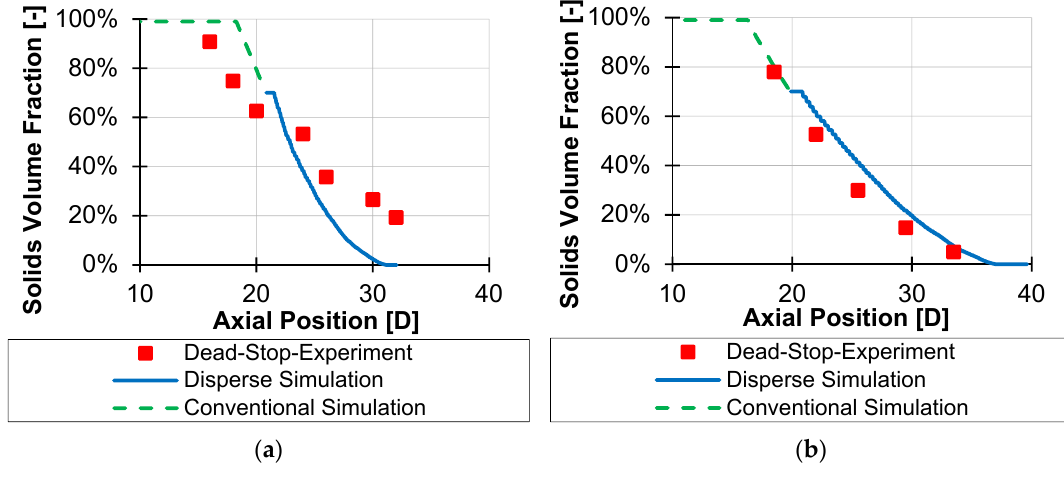
Figure 21. Comparison of measured versus simulated solid contents: investigation points with largest deviation ( a ) and smallest deviation ( b ).